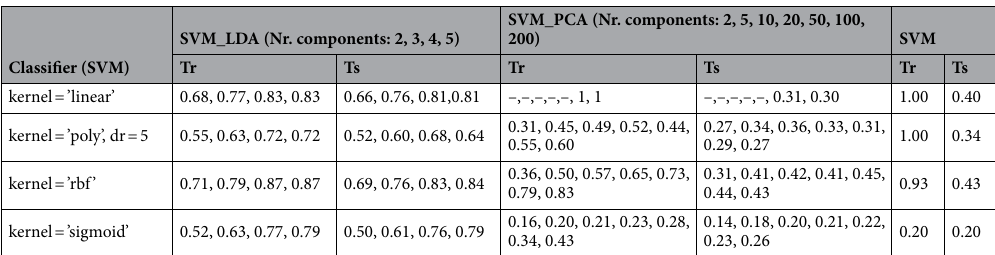
Table 1. Result of snake image classification using SVM algorithm.